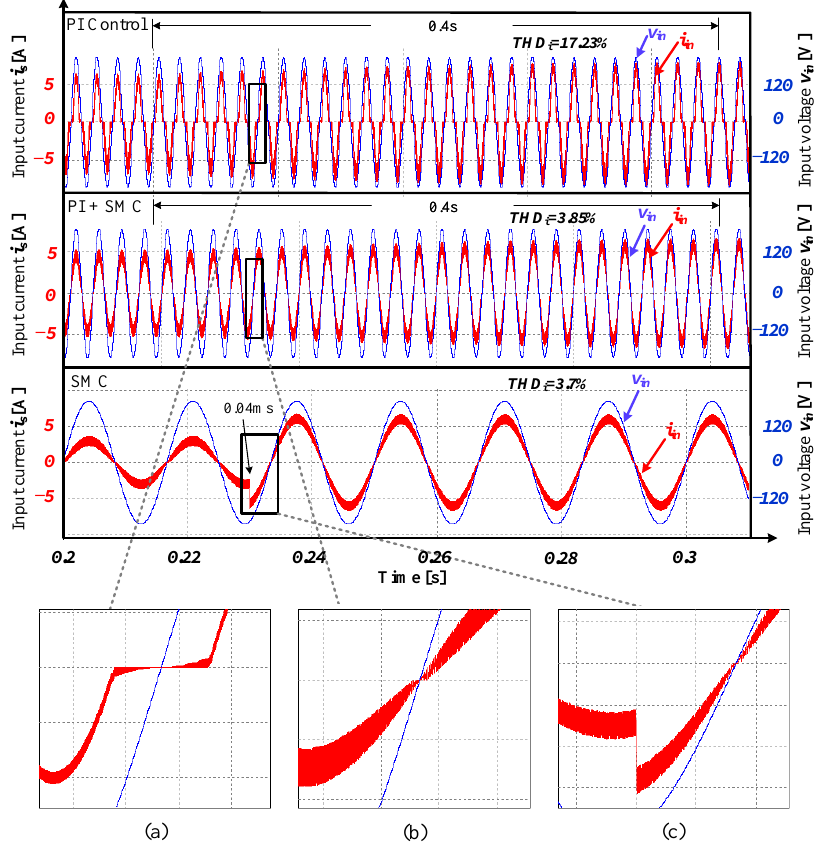
Figure 9. AC current performance of: ( a ) PI control; ( b ) PI-SMC; and ( c ) the proposed SMC.